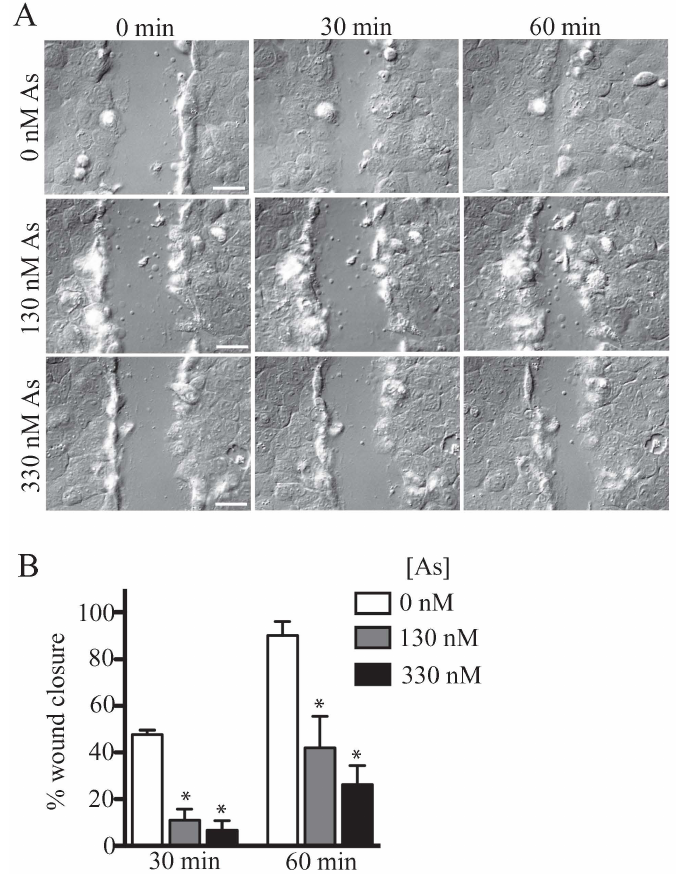
Figure 7. Wound healing assay of 16HBE14o- cells exposed chronically (4–5 weeks) to 0, 130, or 335 nM sodium-arsenite: ( A ) Representative images of initial wounding (left column), 30 min post-wounding (middle column), and 1 h post-wounding (right column). White scale bar represents 50 µM; ( B ) Quantification of percent wound closure over time at 30 and 60 min post-wounding. “*” indicates significant difference from untreated controls by a one-way ANOVA ( p < 0.05). Reprinted with permission from Sherwood et al.